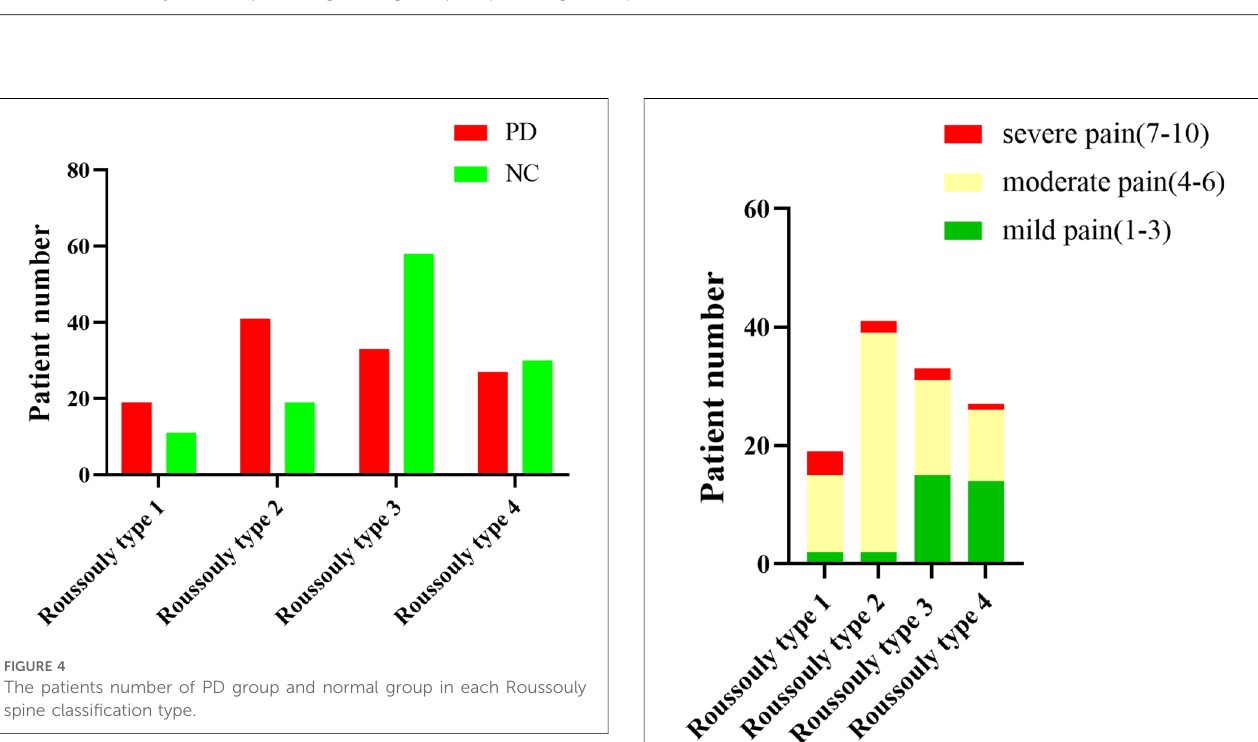
FIGURE 3 The correlation analysis of the pain rating and sagittal spino-pelvic alignment parameters.